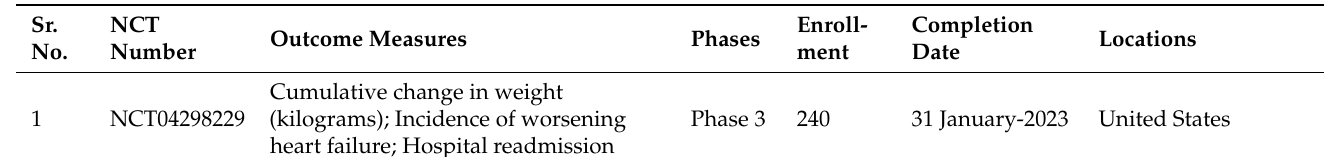
Table 3. Ongoing clinical trial characteristics of outcome measures, phase of study, enrollment, completion date, and